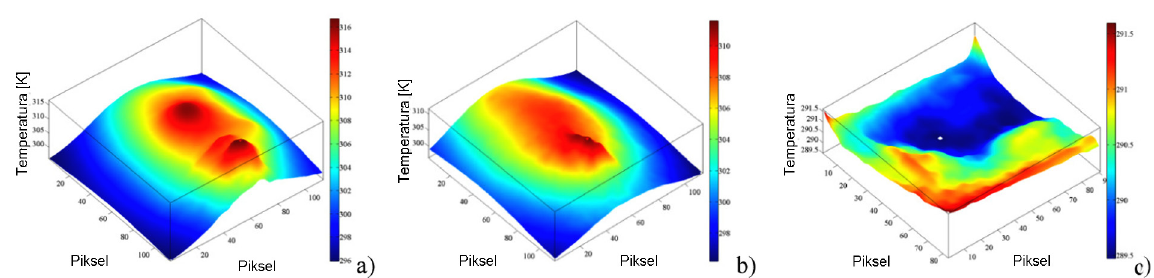
Fig. 2. Optimal thermograms of selected configurations: a) BM 3-1 bottom surface, distance 1.5 m; b) BM 2-2, bottom surface, distance 1.5 m; c) BM 1-3, top surface, distance 3